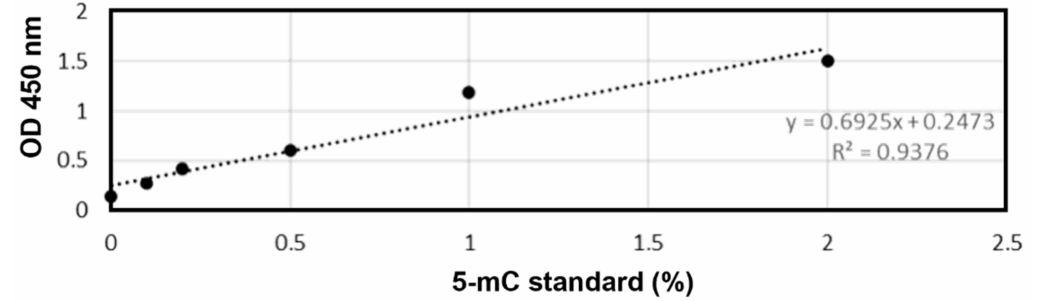
Figure 2. Standard curve for methylated DNA, built using the kit-provided positive controls for validation of the measure- ment method (ELISA Easy Kit